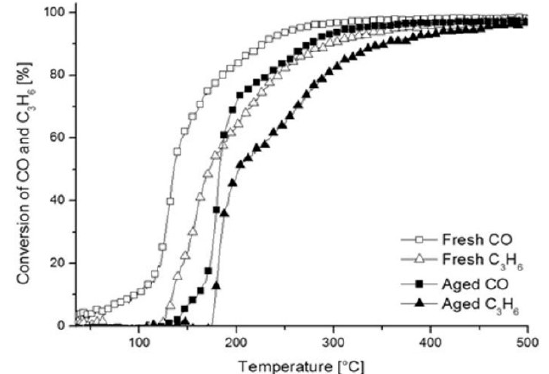
Figure 20. The conversion curves of CO and C 3 H 6 for the fresh and aged natural gas catalysts.